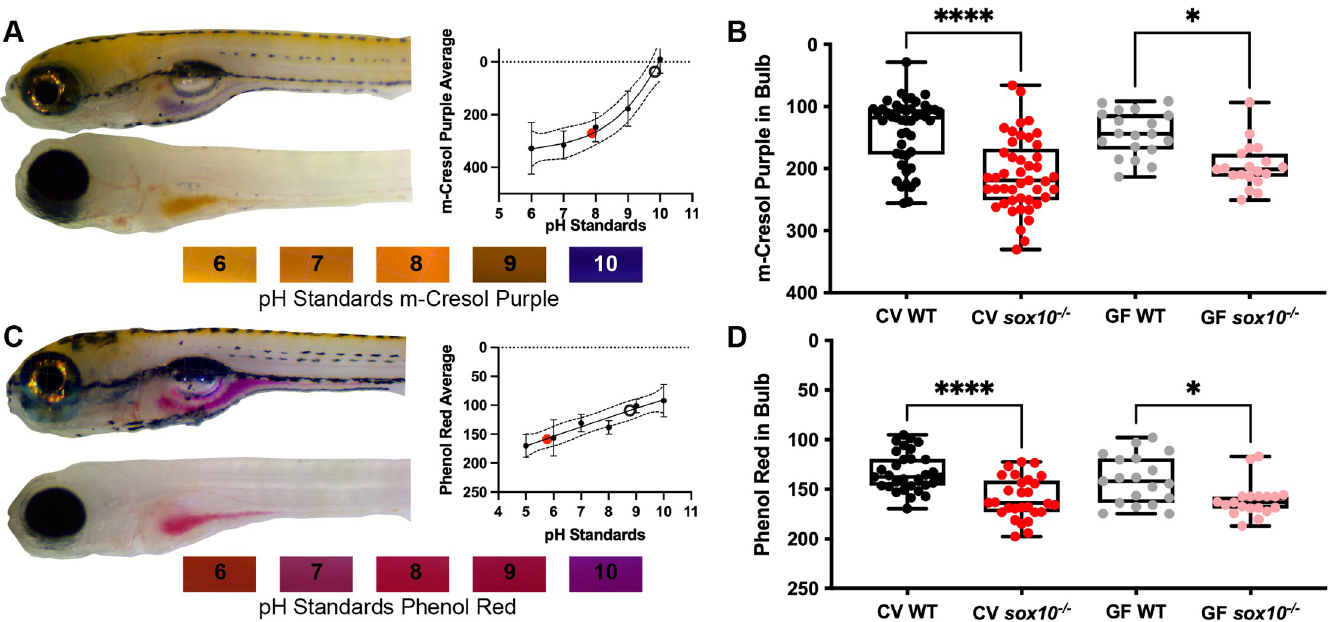
Fig 4. sox10 mutant intestinal lumens are more acidic than wild types. (A) Top left, representative images of WT (top) and sox10 mutant (bottom) larvae 20 min after m-cresol purple gavage. Bottom, pictures of indicator dyes in sterile embryo medium adjusted to known pHs; graph shows quantification of standards. (B) Quantification of luminal pH in intestinal bulb plotting red + green–blue integer values as described in the Methods. (C) Top left, representative images of WT (top) and sox10 mutant (bottom) larvae 20 min after phenol red gavage. Bottom, pictures of sterile embryo medium adjusted to known pHs; graph shows quantification of standards. (D) Quantification of luminal pH in intestinal bulb plotting red integer values. Integer values correspond with red, green and blue channel pixel intensities between 0 and 255 identified with “RGB measure” Image J plugin (see Methods). (A&C) Each dot is an average of at least 3 replicates of pH standard values. Black circle indicates value of WT representative image and red dot indicates value of sox10 -/- representative image. (B&D) Each dot is an individual fish; n > 17 for each condition. Boxes represent the first to third quartiles, center bar denotes the median, and whiskers the maximum and minimum of each dataset. � p < 0.05, ���� p < 00001. ANOVA followed by Tukey’s post hoc test.